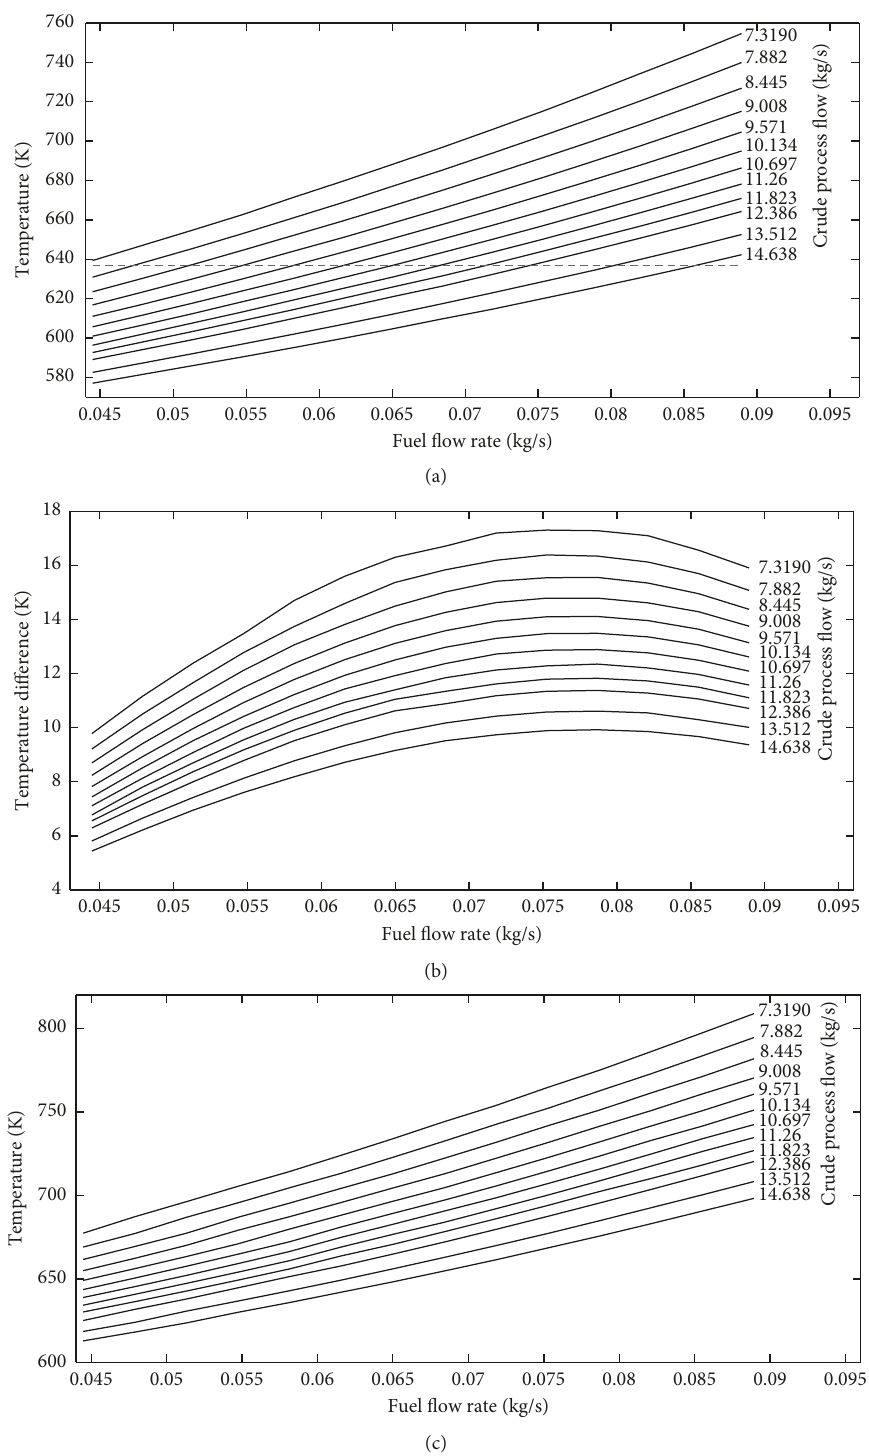
Figure 3: (a) Crude process temperature versus fuel flow rate. (b) The temperature difference of passes versus fuel flow rate. (c) Tube surface temperature versus fuel flow